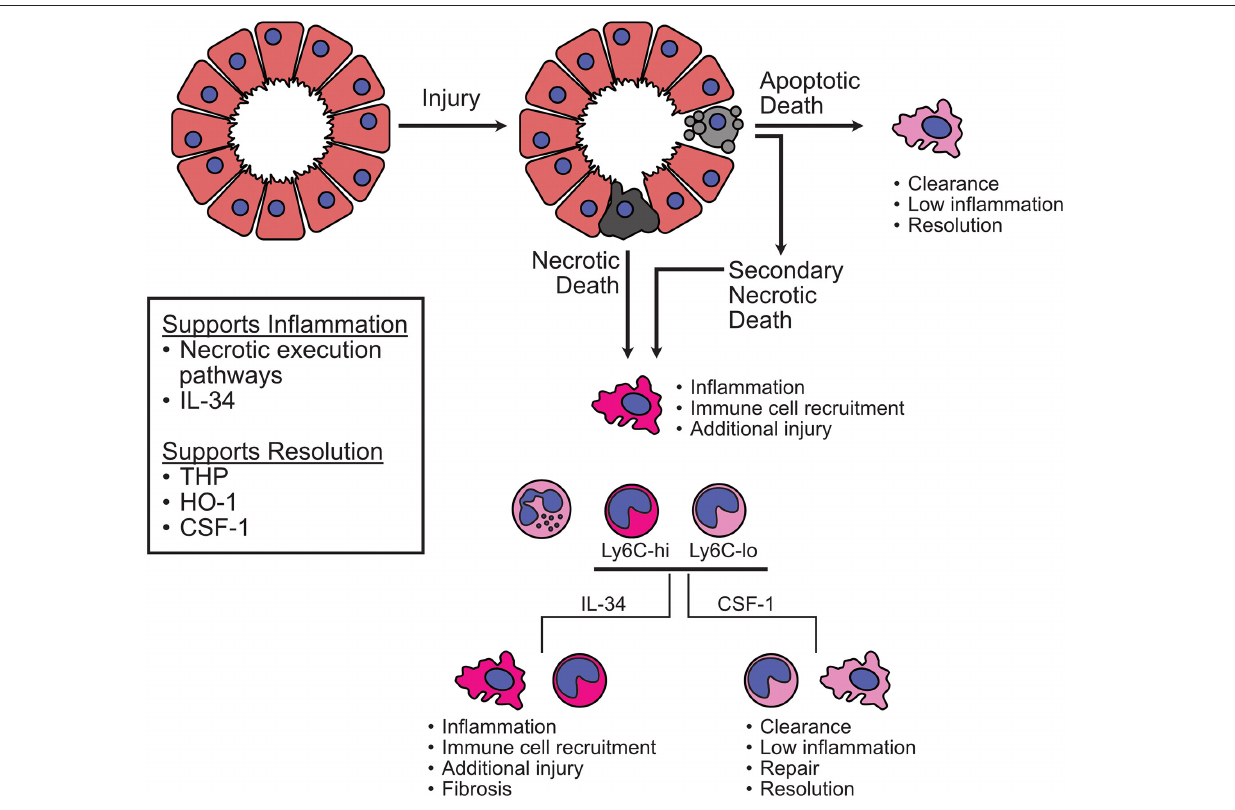
FIGURE 3 | Potential macrophage/monocyte responses to initial injury and regulation via CSF1R during AKI. After initial injury, cell death can occur via multiple pathways. Apoptotic cells can be cleared by efferocytosis and results in relatively low inflammation. If clearance is insufficient to resolve the injury, more inflammatory forms of cell death may pre-dominate, such as necroptosis or necrosis. Based on the evidence discussed in this review, inflammatory cell death can activate resident macrophages to produce proinflammatory molecules and recruit additional cells. This leads to an influx of neutrophils and monocytic cells. Monocytes can transition into additional macrophage populations whose activity is determined by signals from the environment. According to the studies discussed here, IL-34 supports more proinflammatory activity while CSF-1 supports more reparative activity. Interfering with the necroptotic pathway of cell death lessens injury-induced inflammation and promotes recovery. THP appears capable of enhancing the phagocytic function of macrophages, which supports clearance and resolution. HO-1 allows for the breakdown of toxic free heme to lessen injury and inflammation. Overall, a balance must be struck between interrupting progressive inflammation and injury while supporting clearance of damaged material and